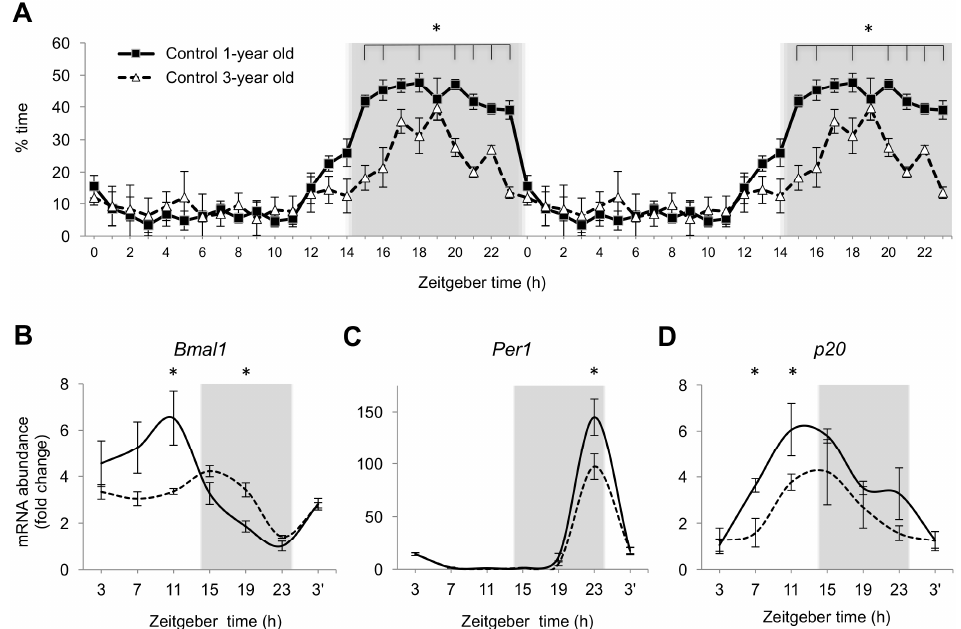
Figure 4. Age-dependent changes in nighttime sleep and the expression of core clock genes and cell cycle regulator in 3-year old zebrafish undergoing normal aging. ( A ) Double-plot of percent time spent in sleep over a 24-h period. Black circle—1-year old Control, open triangle—3-year old Control. n = 12 fish per group. ( B – D ) Fold change in mRNA abundance over a 24-h period for the core clock genes ( Bmal1 , Per1 ) and CDC regulator, p20 , in 1-year old (solid line) and 3-year old (dashed line) Control fish, relative to within-group minimal expression, n = 5–6 fish per time point per group. In ( A – D ): Mean ± SEM, * p < 0.05 3-year old vs.1-year old Control at each time point. Grey background—night, 14:10 LD cycle. Zeitgeber time of sample collection, ZT0 = lights-on time.